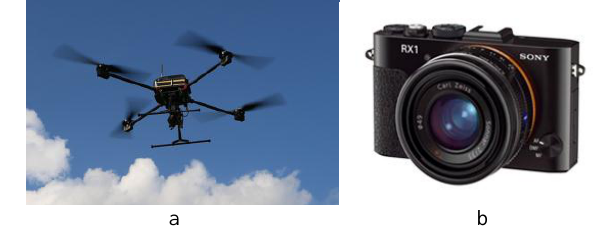
Figure 10. (a) Unmanned aerial vehicle Geoscan 401 (b) Sony - RX1 digital camera 4.1.2